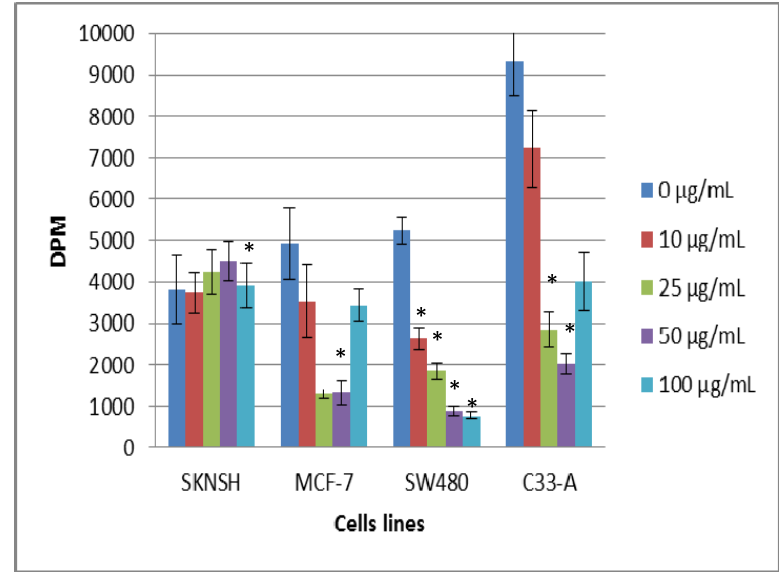
Figure 6. Effect of lectin on cell proliferation after 24 h during which lectins were removed from the cells, employing the 3 [H]-thymidine assay. The cells were previously incubated for 24 h with lectin solution; then, the solution was removed and the cells were incubated for only 24 h with the cell culture solutions [Dulbecco’s modified Eagle’s medium (DMEM) and fetal bovine serum (FBS)]. All values are expressed as mean ± SEM of three independent